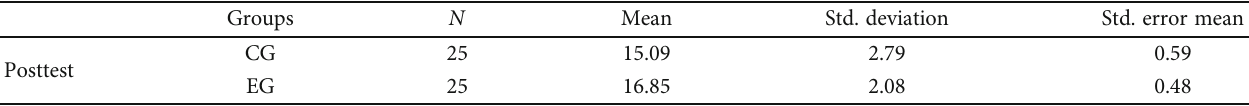
Table 3: Group statistics (immediate posttest of both groups).